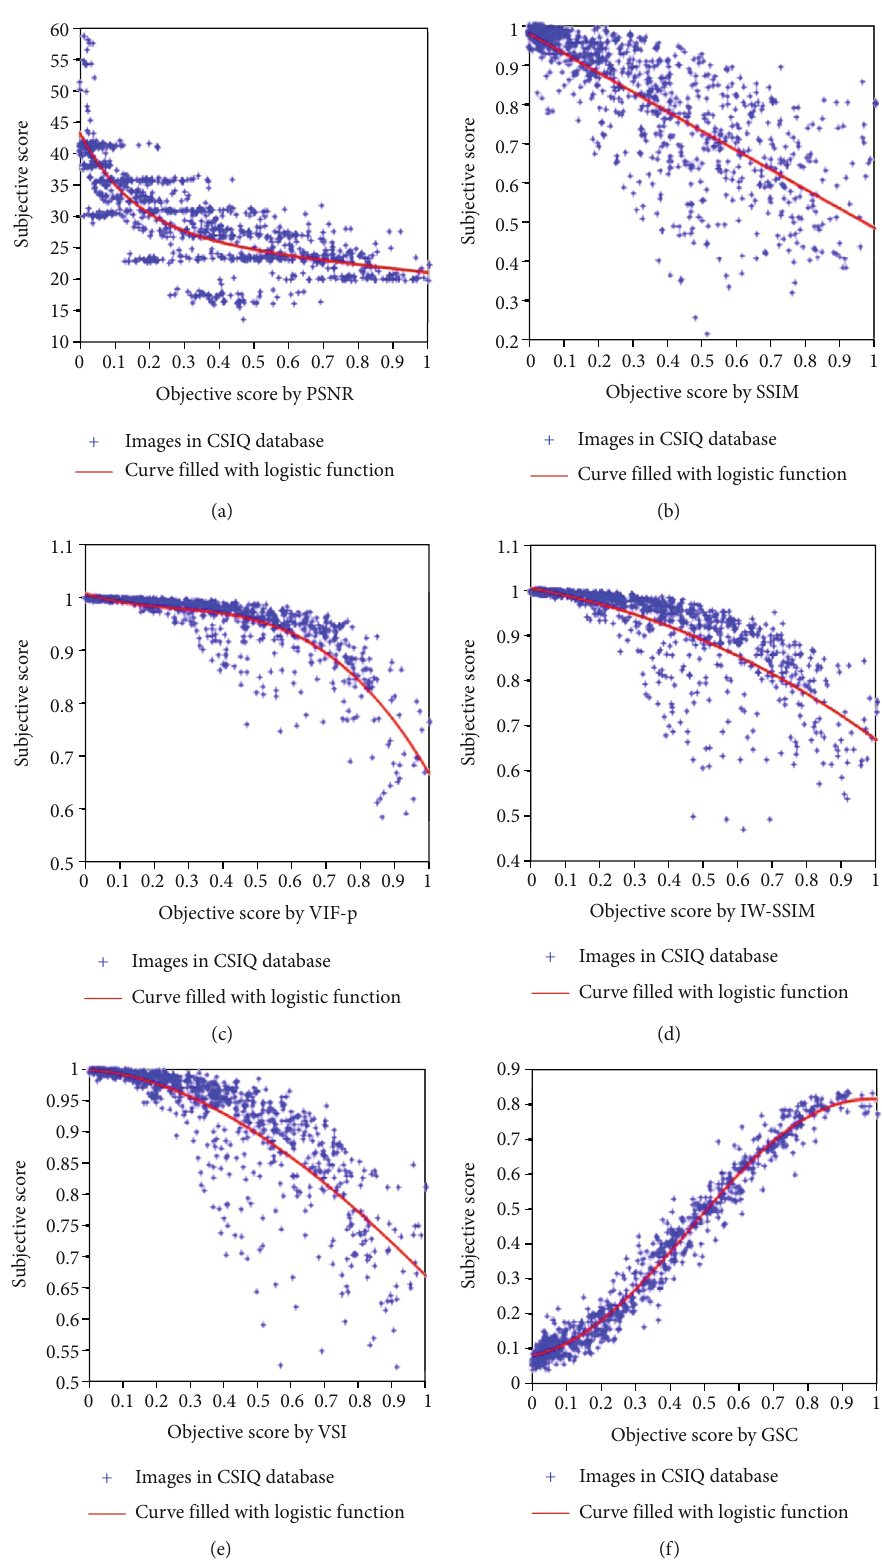
Figure 3: Scatter plots of the predicted value of the distorted image data model compared with the subjective evaluation scores on CSIQ database. (a) PSNR, (b) SSIM, (c) VIF-p, (d) IW-SSIM, (e) VSI, and (f)